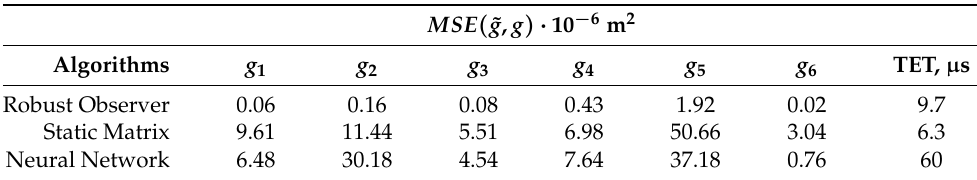
Table 1. Comparison of identification